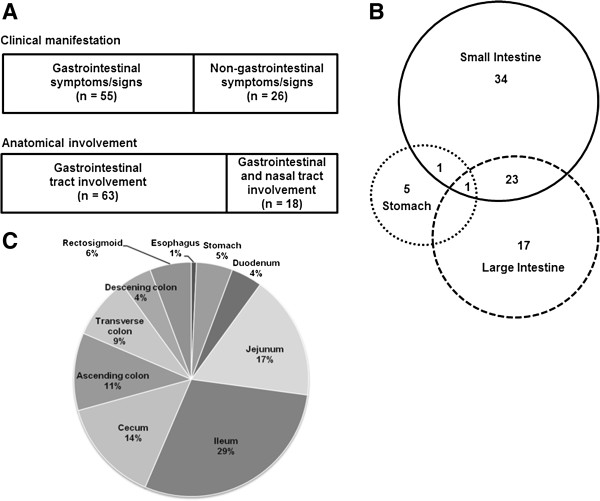
Clinical manifestation and gastrointestinal tract involvement. (A) Comparison of clinical manifestation and anatomic involvement (B) Pattern of gastrointestinal tract involvement. (C) Frequency of involvement of each part of the GI tract by extranodal NK/T-cell lymphoma from the esophagus to the recto-sigmoid colon (The percentage of each part of GI tract = the number of patients involving each part/total number of involved parts in 81 patients × 100).